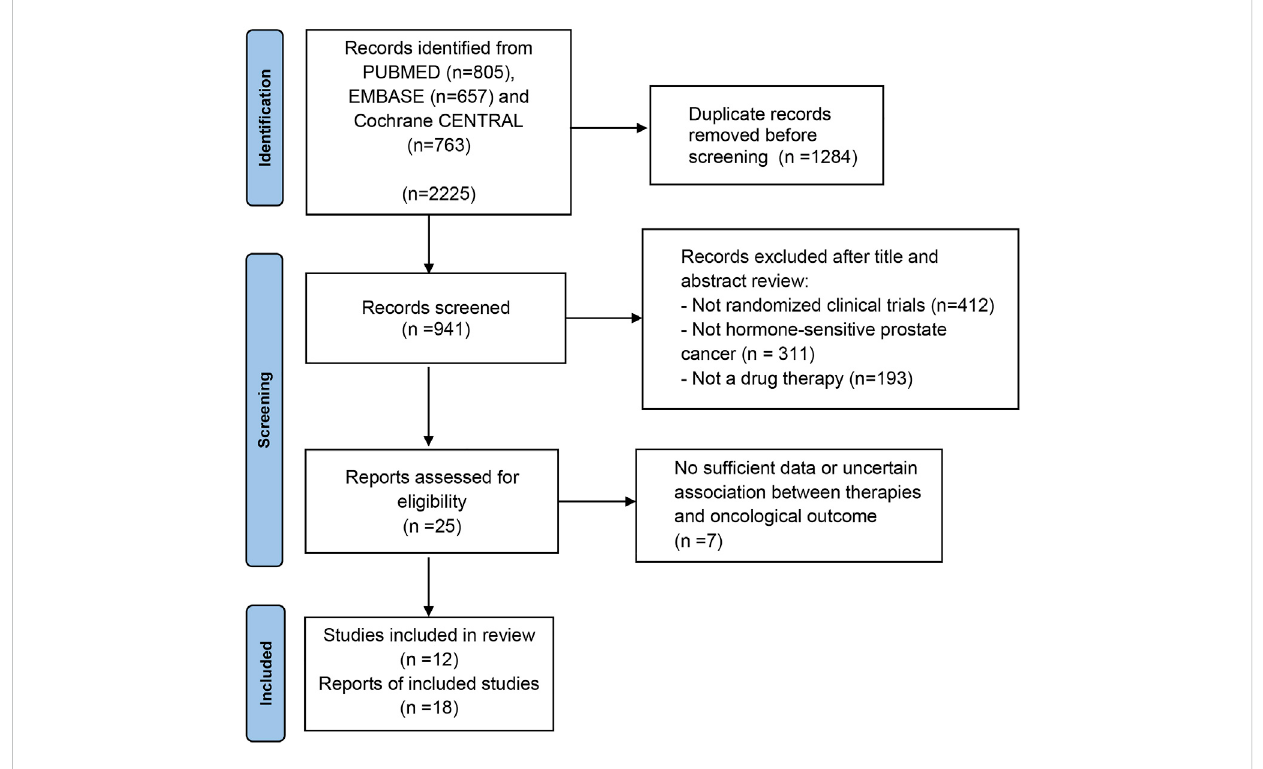
FIGURE 1 The PRISMA fl ow chart detailing the article selection